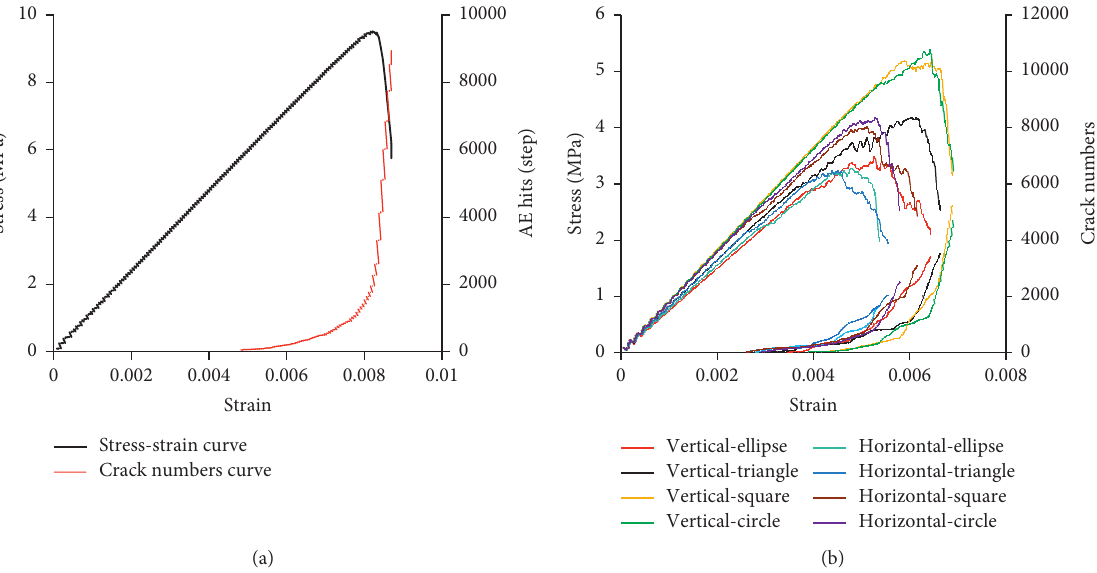
Figure 6: Stress-strain curve and crack number-strain curve of intact rock and rock holes with different shapes. (a) Intact rock. (b) Rock holes with different